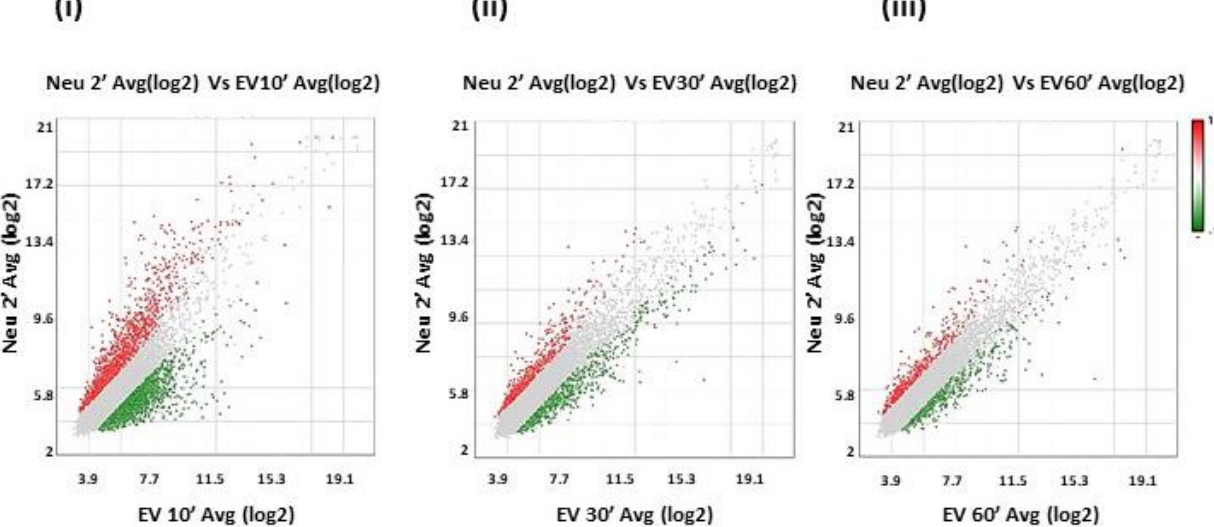
Figure 2. Transcriptomic analysis of CTC EVs incubated with neutrophils; ( A ): Principal Component Analysis (PCA) of microarray data obtained by hybridization of mRNA extracted from control neutrophils at time points (2′ and 30′) and experimental samples, i.e., neutrophils treated with EVs and collected at time points 2′, 30′, and 60′; ( B ): Scatter plot representing the average (log2) fold change of genes expressed in neutrophils at 2 min vs. average (log2) fold change of genes expressed in neutrophils treated with EVs from CM61 cell line at time points (i). 10′, (ii). 30′, and (iii). 60′.